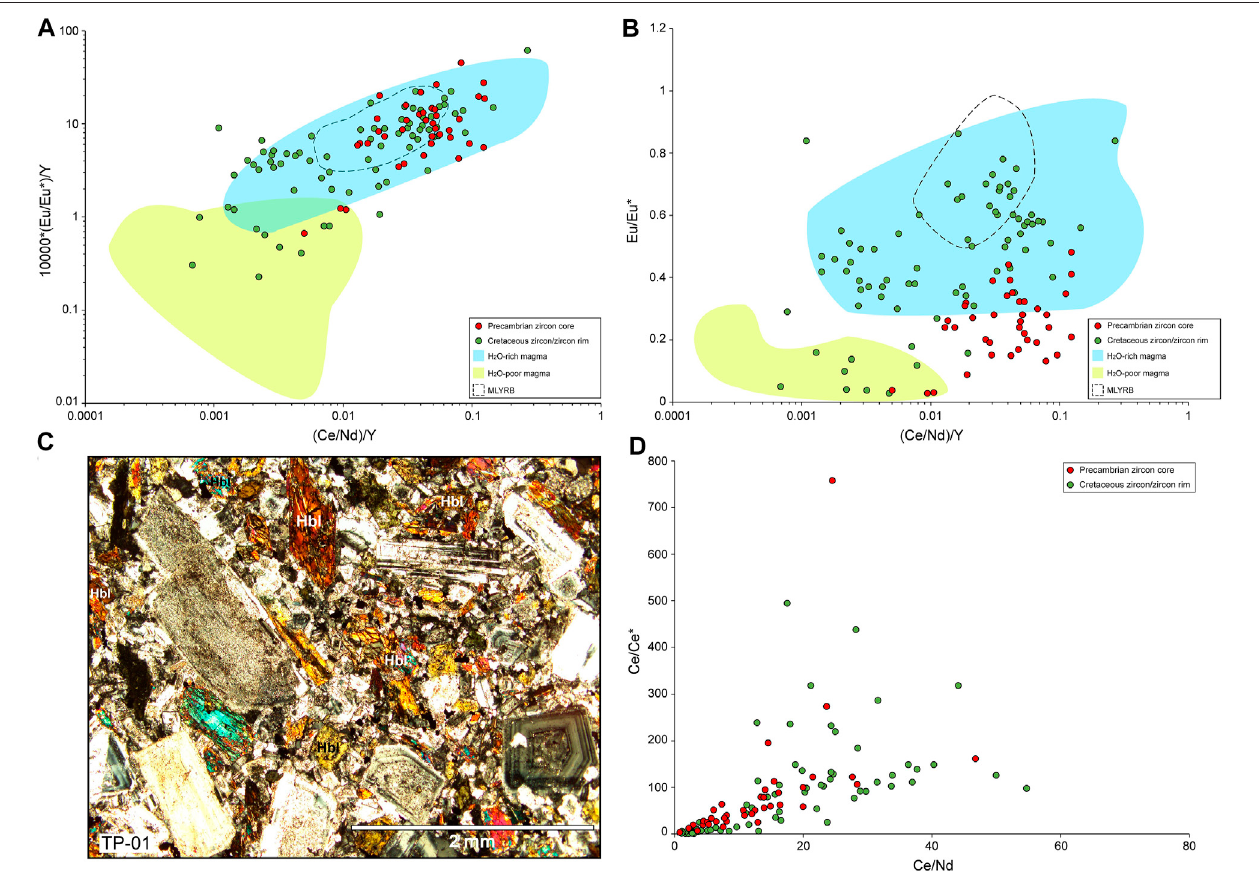
FIGURE14|(A) 10000*(Eu/Eu*)/Yvs.(Ce/Nd)/Yand (B) (Eu/Eu*)/Yvs.(Ce/Nd)/YplotsforzirconsfromtheHuaibei-Linhuanintrusiverocksamples(basemapfrom Lu et al., 2016); (C) Thin-section microscopic photos showing the abundance of igneous hornblende in Taiping diorite (TP-01); (D) Zircon Ce/Ce* vs. Ce/Nd plot for the Huaibei-Linhuan intrusive rock samples, showing that Ce/Nd is a good proxy for Ce anomalies.